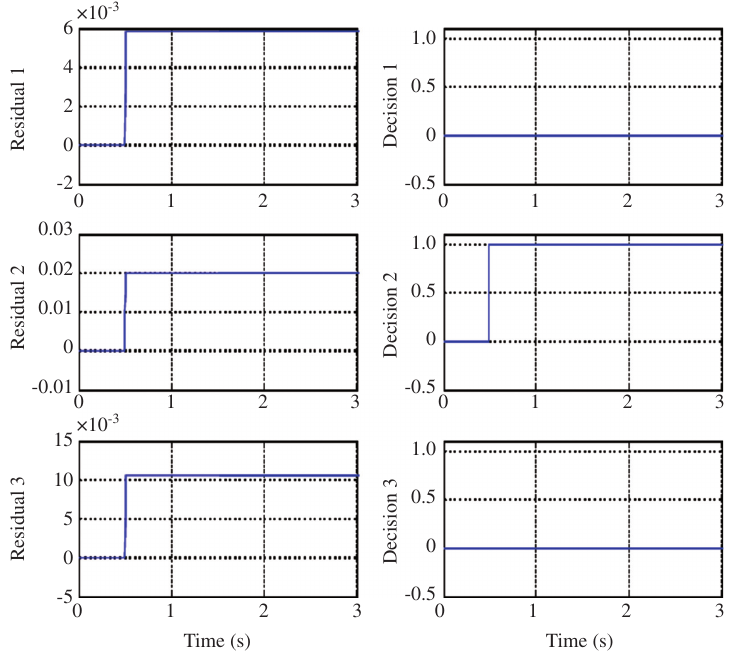
Figure 5. Residuals with a Non-additive Fault on Joint 2 at t = 0.5